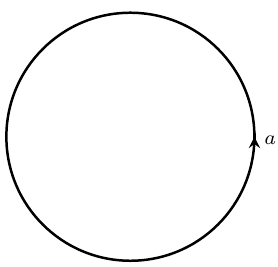
Figure 6 . A loop of line a constructed by composing evaluation and co-evalutaion morphisms. The loop, if it contains no other operators in it, can then be shrunk and the partition function with the loop is equal to dim CC a = dim a times the partition function without the loop, with all other insertions